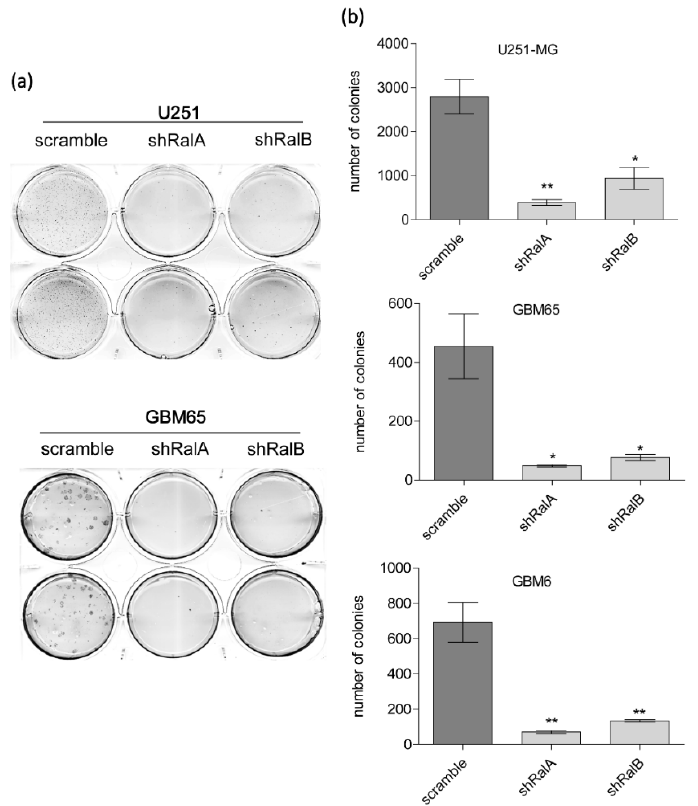
Figure 3. Knockdown of Ral GTPases reduces soft-agar colony growth. U251-MG cell line, GBM65, and GBM6 were infected with lentivirus-mediating interference RNA against RalA or RalB and seeded in a soft agar layer. After 15 days, the growing colonies were stained by MTT reaction, and the plates were scanned. ( a ) Representative images of U251-MG and GBM65 plates. ( b ) Diagram representing the number of colonies quantified with the ImageJ program. Values represent mean ± SEM ( n = 4). Significance was calculated by ANOVA and Tukey-HSD post-test. Significance of scramble versus shRalA and shRalB groups is represented (* p ≤ 0.05; ** p ≤ 0.01).